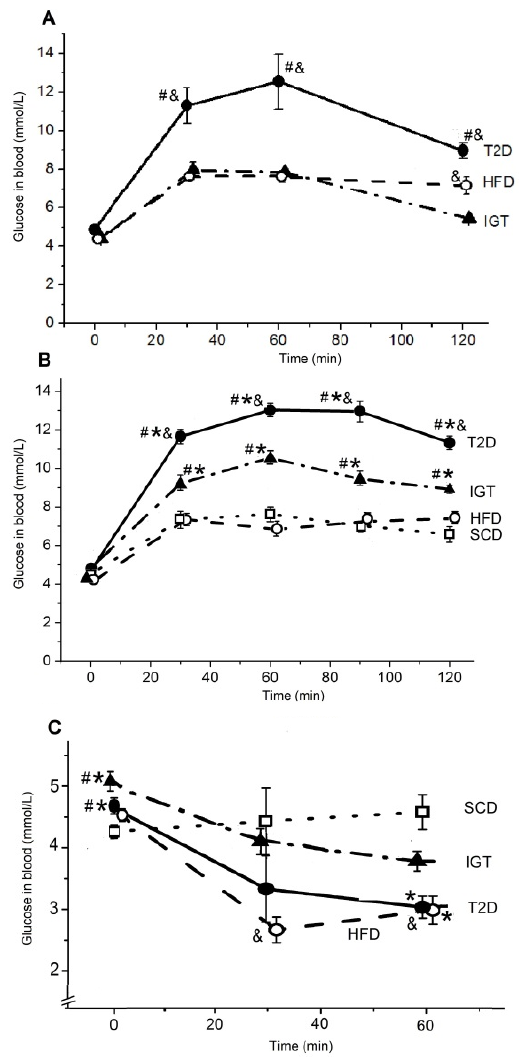
Figure 3. Results of the oral glucose tolerance test (OGTT) and the insulin tolerance test (ITT) in the rats in the groups with type 2 diabetes (T2D), with impaired glucose tolerance (IGT) and in control groups: high-fat diet (HFD) and standard chow diet (SCD). ( A ) The OGTT was performed 2 weeks after the administration of streptozotocin or its solvent. ( B ) The OGTT was performed 10 weeks after the administration of streptozotocin or its solvent to the rats. ( C ) The ITT was performed 11 weeks after the administration of streptozotocin or its solvent. ( A – C ) The T2D group ( n = 4), the IGT group ( n = 6), the HFD group ( n = 6) and the SCD group ( n = 6). Results are expressed as means ± the standard error of the mean (SEM). Two-way ANOVA: * p < 0.05 compared with the SCD group, # p < 0.05 compared with the HFD group, & p < 0.05 compared with the IGT group. As seen in Figure 3B, the long-term high-fat diet (HFD) did not affect the blood glu- cose levels of animals who were measured after 18 h of fasting, as well as the levels of this indicator at 30, 60, 90 and 120 min after the oral administration of the glucose solution (at a dose of 2 g glucose/kg body weight). Even after 120 min, glucose levels in the HFD group were only slightly higher than in the SCD group ( p > 0.05). In rats of the IGT and T2D groups, the blood glucose level at all periods after the oral administration of glucose was significantly higher than in the SCD and HFD groups ( p < 0.05). In addition, in the T2D group, blood glucose levels were higher compared to the SCD group ( p < 0.05). During ITT (Figure 3C), 30 and 60 min after insulin administration, the blood glucose level of rats in the SCD group did not change, while in the HFD, IGT and T2D groups, this parameter was noticeably reduced compared to the initial level (0 min) ( p < 0.05 paired Wilcoxon test). The most pronounced decrease in the blood glucose level took place in rats of the HFD group 30 min after the administration of insulin ( p < 0.05 compared with the IGT group). These data confirm the presence of insulin resistance in the HFD, IGT and T2D groups, which is more pronounced in the IGT and T2D groups. 3.3. The Number of Enterocytes and Goblet Cells on the Villi of the Jejunum and Ileum The long-term high-fat diet in the HFD group in the period from 4 weeks after birth to about 23 weeks of age did not significantly affect the cell count in the villi of the jejunum and ileum (Figure 4).